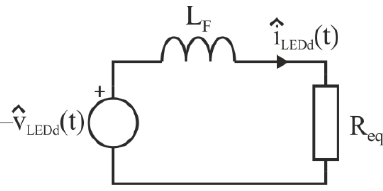
Figure 8. Small signal dynamic behavior approach.